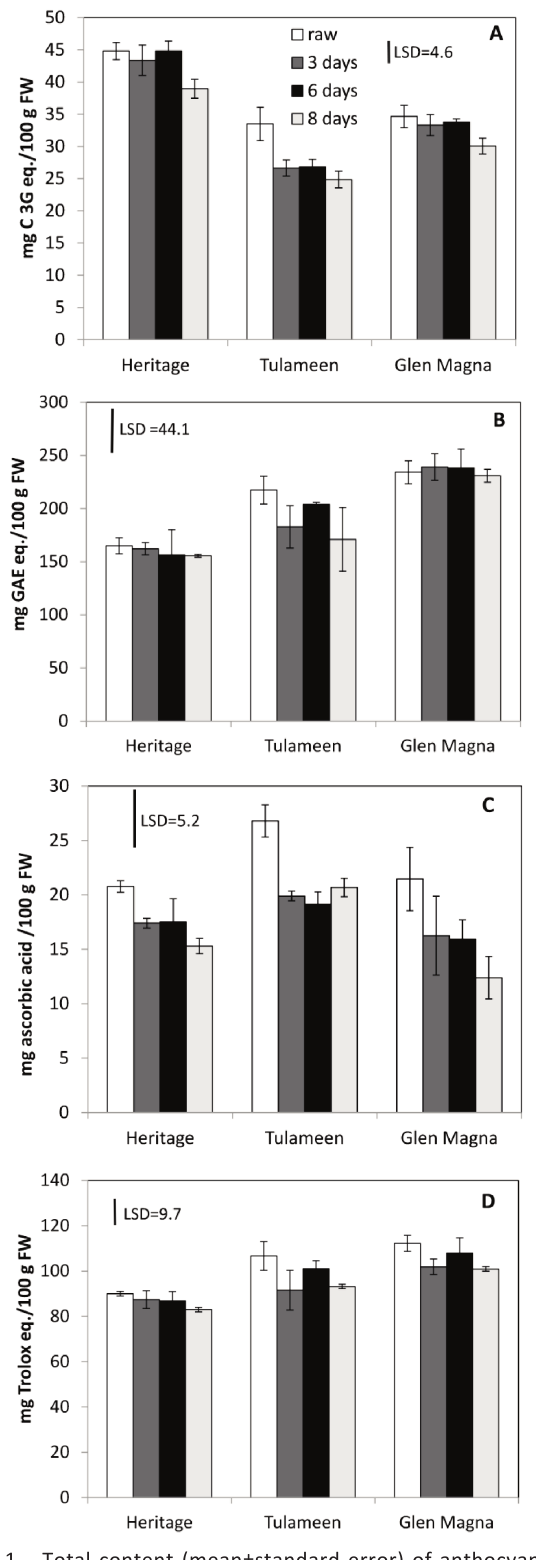
Fig. 1 - Total content (mean±standard error) of anthocyanins (A), phenols (B), Ascorbic acid (C) and total scavenging activity (D) measured in ready-to-eat samples from three raspberry cultivars, at harvest (raw) and after 3-6-8 days of shel-life at 3°C. The least significant distance (LSD) for P≤0.05 is indicated on every single